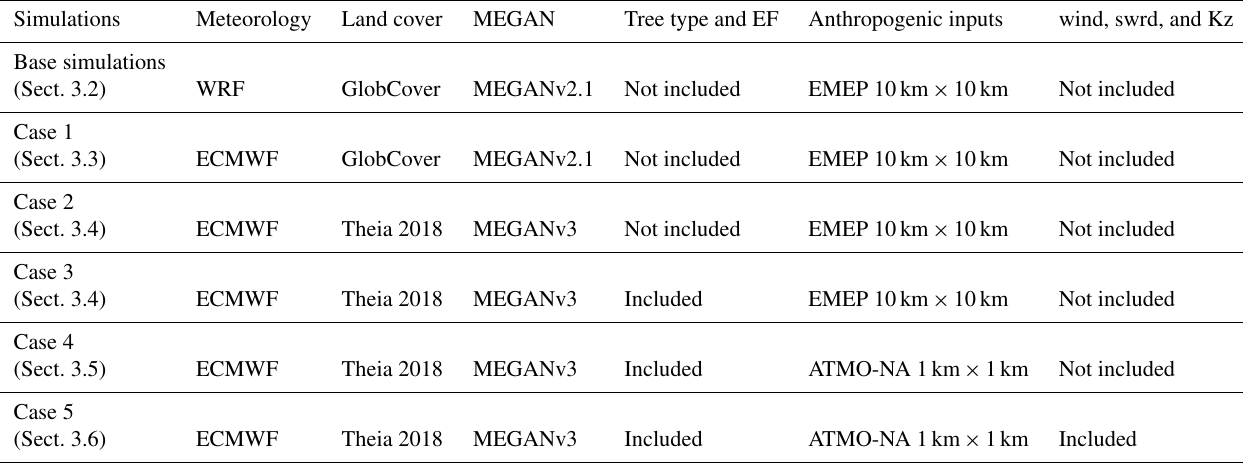
Table 1. Summary of changes in each test case. Each change is explained in more detail in Sects. 3.1 through 3.6. The “tree type and EF” column refers to changes in tree type inputs and their respective emission factors. The “wind, swrd, and K z ” column refers to the test case in which the inside-canopy wind speed, shortwave radiation, and vertical exchange coefficient parameters are modified. For each case the section of this paper in which the changes are explained is mentioned in the first